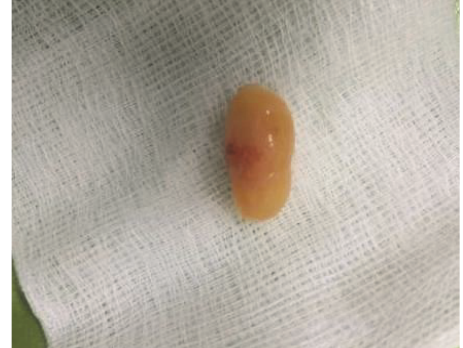
Figure 4: Penile plexiform schwannoma. Surgical specimen after excision: yellowish, spindle-shaped, and elastic in